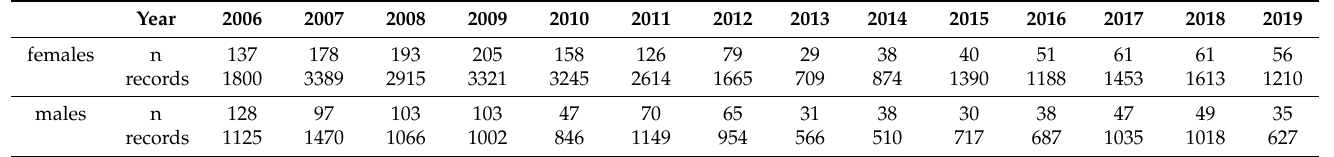
Table 2. Number of female and male red deer (n) and number of records across years